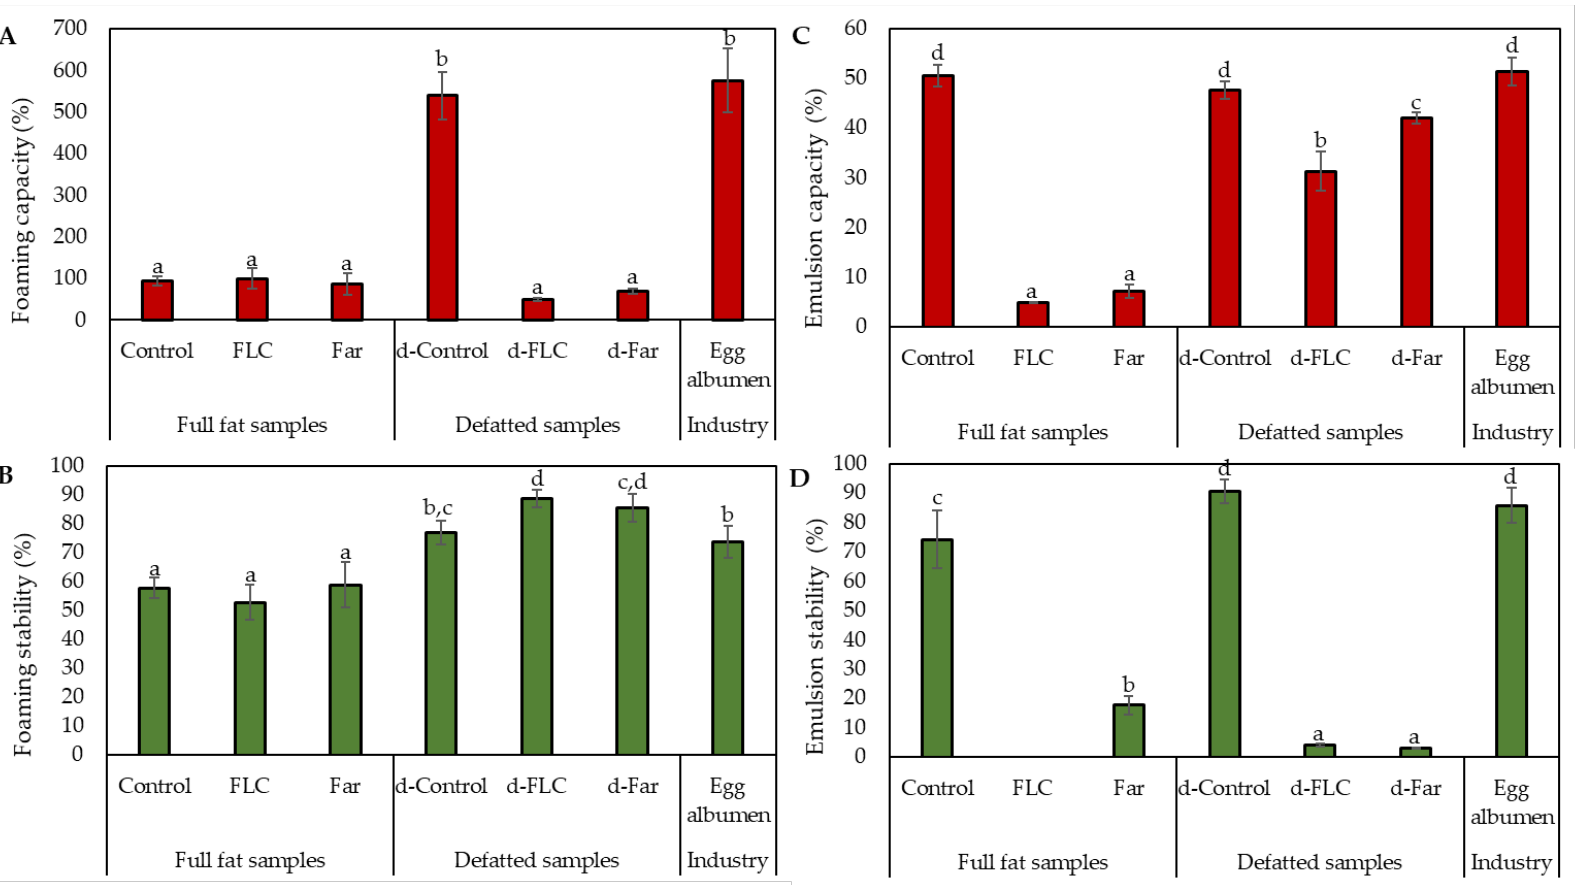
Figure 3. Foaming capacity ( A ), foaming stability ( B ), emulsion activity ( C ) and emulsion stability ( D ) of extracted protein solutions (0.25% w / v ) from full fat (Control and the fermented samples FLC and FAR) and defatted (d-Control and the fermented samples d-FLC and d-Far) mealworm powders. Egg albumen solutions (0.25% w / v ) were included as reference. Data are expressed as mean ± standard deviations ( n = 5). Different letters (a,b,c,d) indicate significant ( p < 0.05) differences between means.